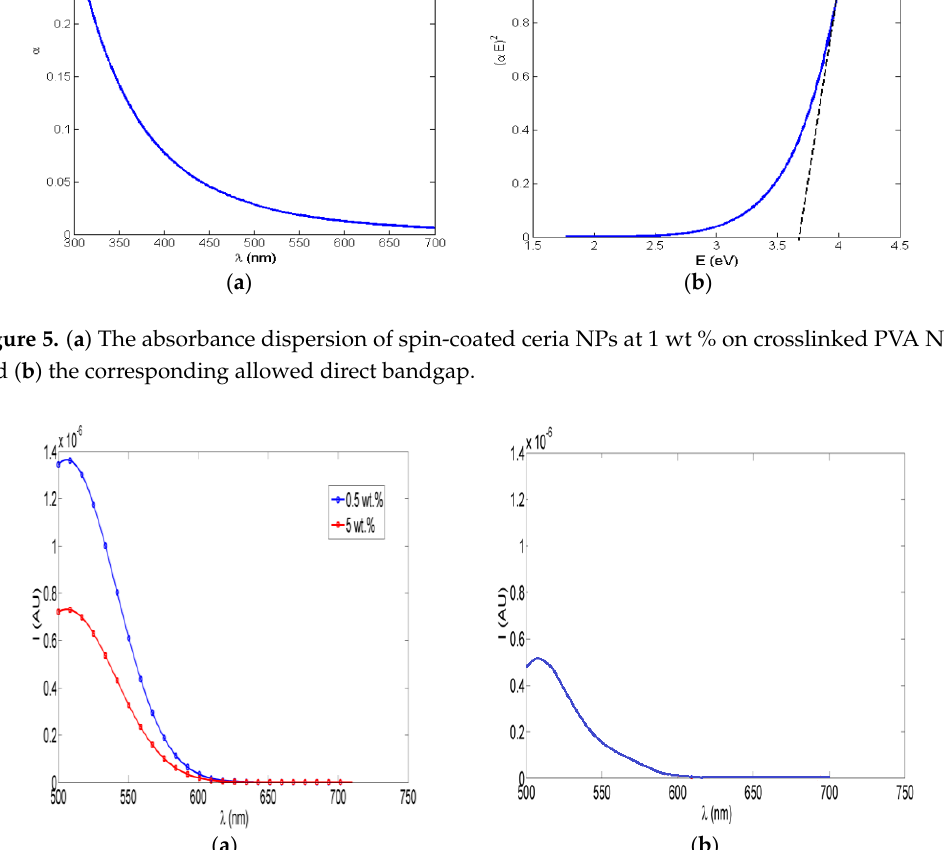
Figure 6. ( a ) Fluorescence intensity of crosslinked PVA NFs with in situ embedded different concentrations of ceria NPs; ( b ) Fluorescence intensity after immersing the crosslinked fiber in water.